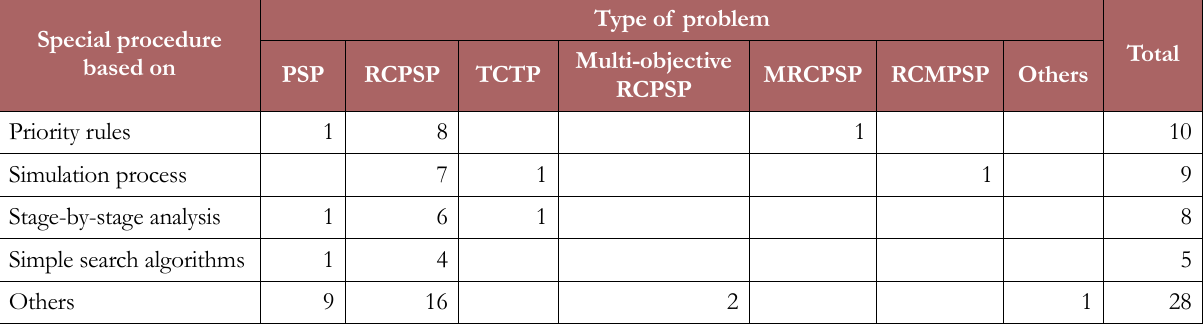
Table 6. Special procedures